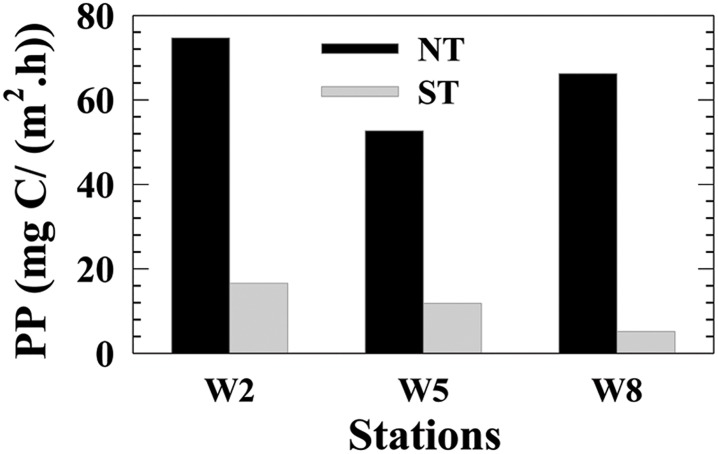
Primary productivity (PP, mg C/(m2.h)) of the transect during NT and ST.